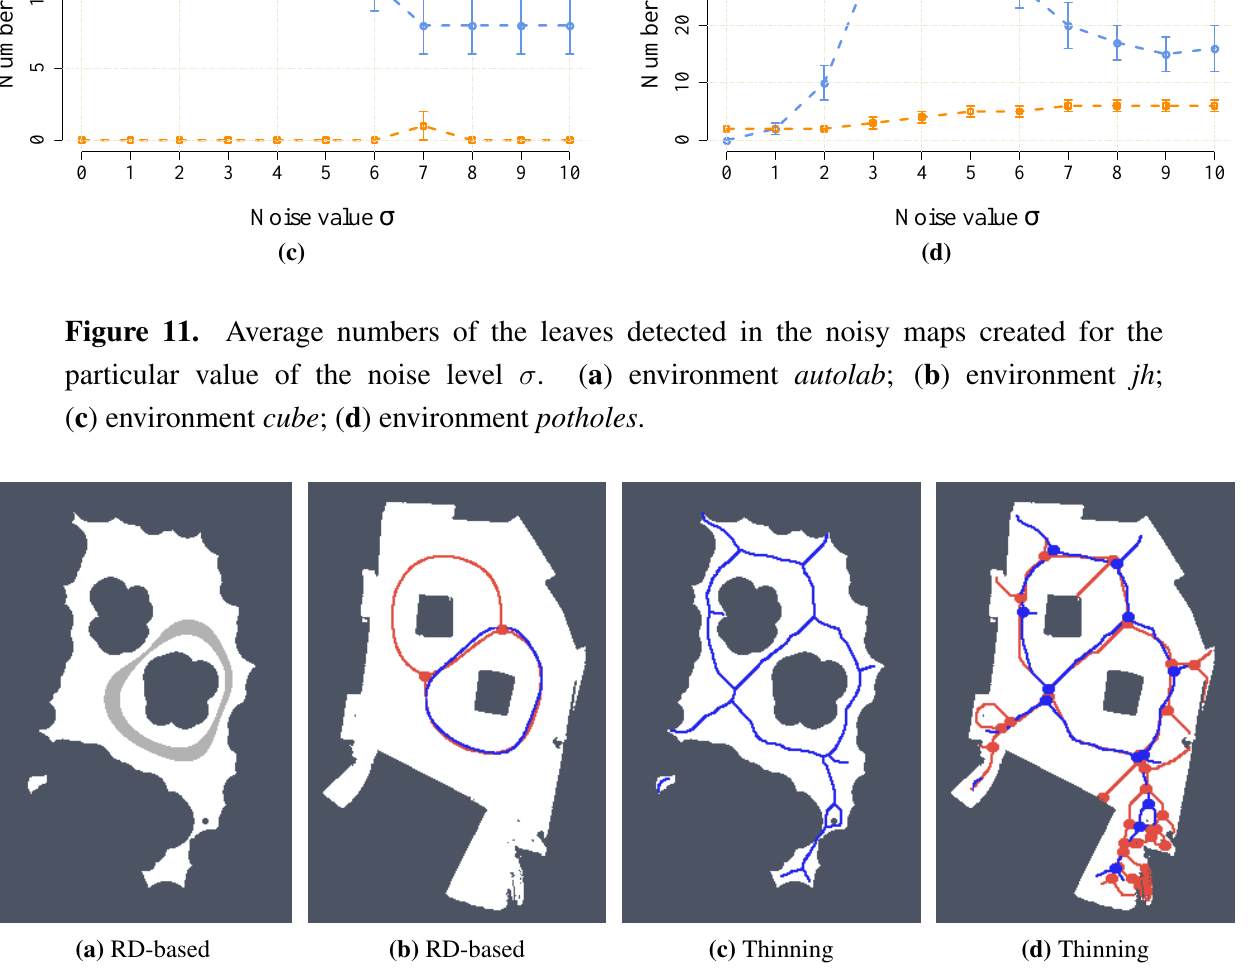
Figure 12. Skeletons and the determined topological maps with highlighted junction places and leaves in the map cube with the noise level σ = 7 : ( a ) RD-based Voronoi diagram; ( b ) and its corresponding skeleton (shown in green) that is superimposed on the skeleton determined in the noise-less map (in red); ( c ) Pruned GVG representing skeleton of the map determined by the thinning algorithm [12]; ( d ) and the corresponding skeleton superimposed on the skeleton determined in the noise-less